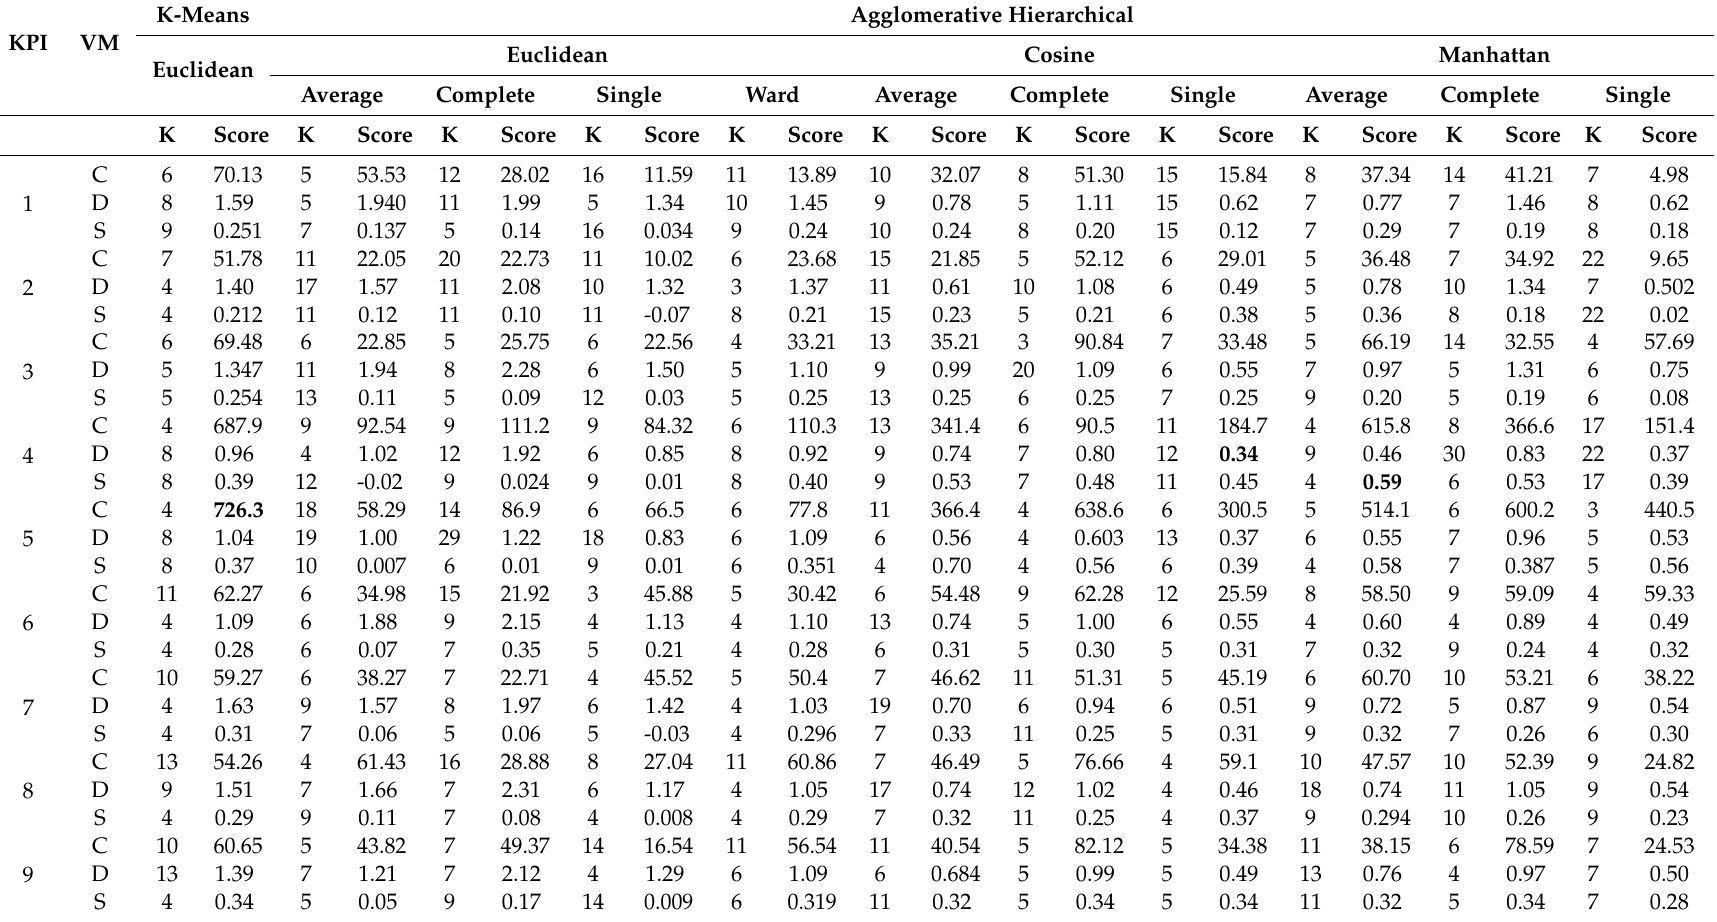
Table A1. Experiment two: